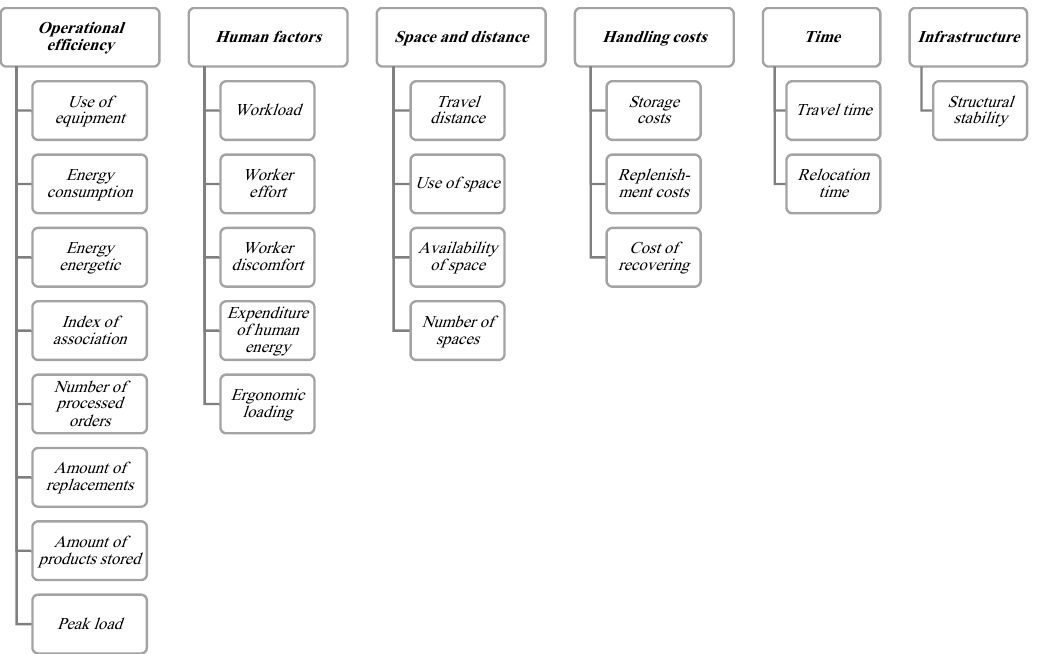
Fig. 13. Classification of performance